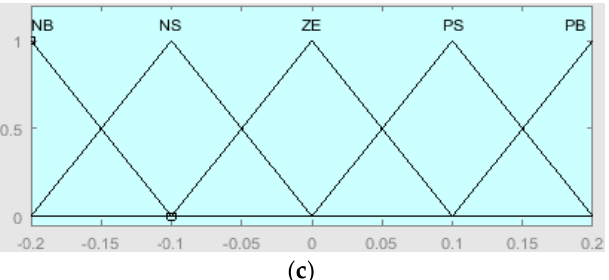
Figure 16. Input ( a , b ) and Output ( c ) Membership Functions of F-LC for WTIG System. Table 8. F-LC MPPT for WTIG System Rule Base.